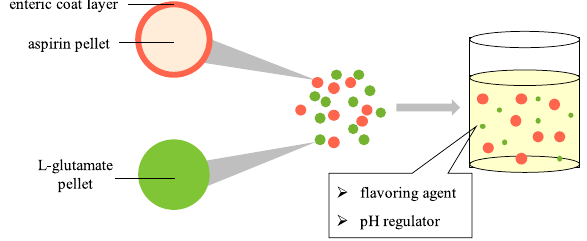
Fig. 3 The schematic diagram of aspirin and L-glutamate compound enteric-coated